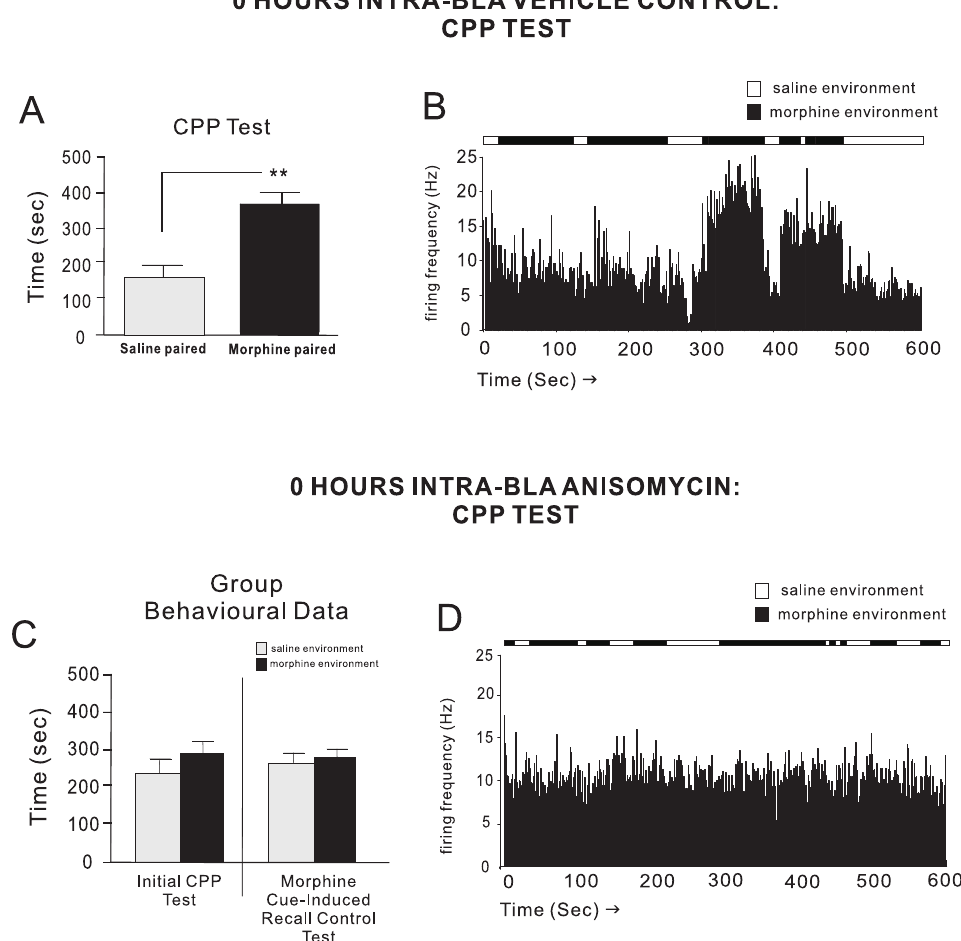
Figure 7. Effects of acute (0 hr) intra-BLA protein synthesis inhibition on behavioral CPP expression and mPFC neuronal activity. A , Group data showing robust behavioral morphine CPP from rats receiving intra-BLA vehicle at 0 hrs post-conditioning. B , A sample rastergram from a single rat, showing typical mPFC neuronal associative responding across saline vs. morphine-paired environments during real-time CPP testing. C , Group data showing blockade of behavioral morphine CPP expression from rats receiving intra-BLA anisomycin at 0 hrs post-conditioning. D , Sample rastergram from a single rat, showing mPFC neuronal responding during real-time CPP testing, across saline or morphine-environmental exposure. Associative neuronal increases during morphine environmental exposure is absent, consistent with a lack of behavioral CPP expression.